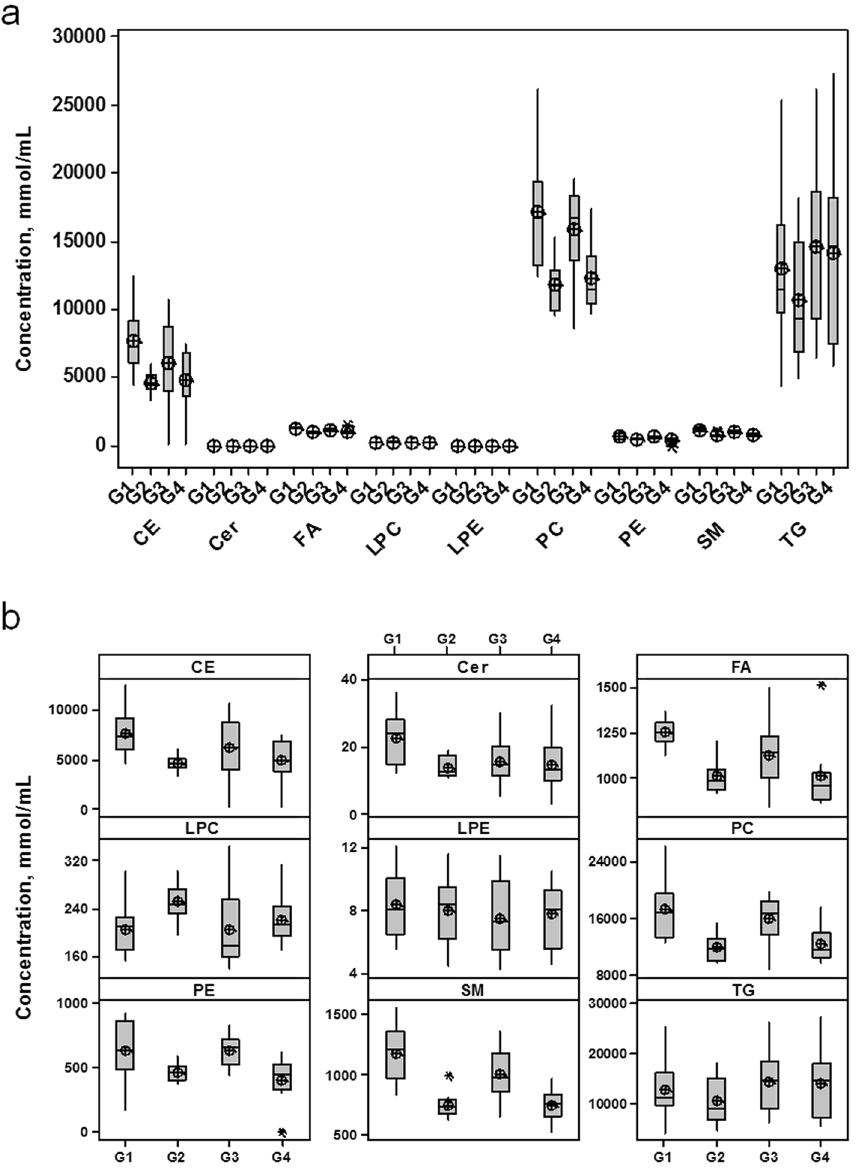
Figure 2. Evaluation of lipid classes for the infarcted patients under evaluation itemized by class ( a ) and by group ( b ). CE cholesterol ester, Cer ceramides, FA free fat acids, LPC lysophosphatidylcholine, LPE lysophosphatidylethanolamine, PC phosphatidyl choline, PE phosphatidylethanolamine, SM sphingomyelin, TG triacylglycerides; group labels as in Fig. 1. Figure was created in Minitab 17.0 (Minitab Statistical Software; URL: https:// www. minit ab. com/ pt- br/) and Microsoft PowerPoint 2013 (URL: https:// www. micro soft. com/ pt- br/ micro soft- power point- 2013). ±Mean